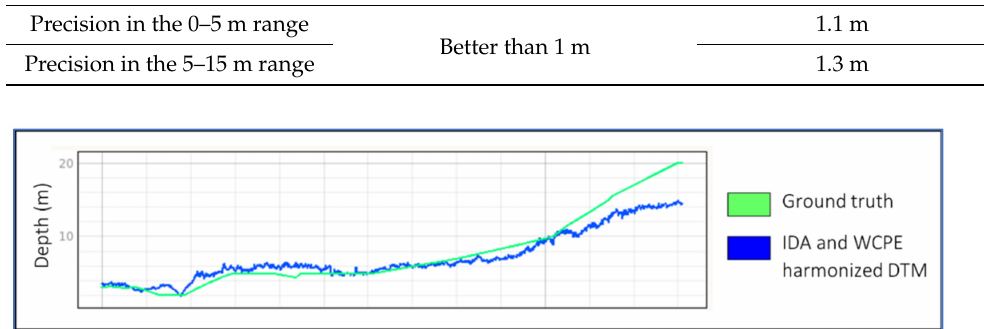
Figure 31. Comparison between WCPE/IDA harmonised DTM and ground truth. The depth of penetration is limited to 11/15 m due to turbidity.